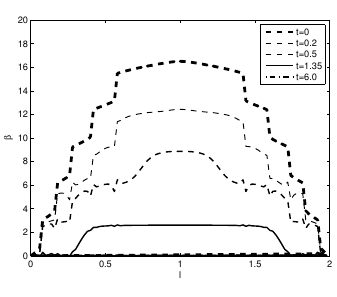
Figure 25. The dependence of β ( l,t i ) on l for ωτ = 24 ⇒ 0, t f = 6 and using reverse